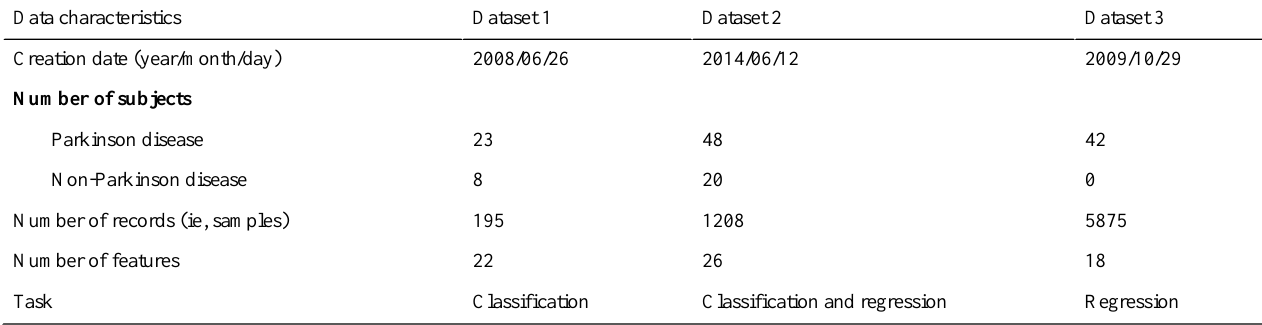
Table 4. Characteristics of three datasets from the University of California Irvine.